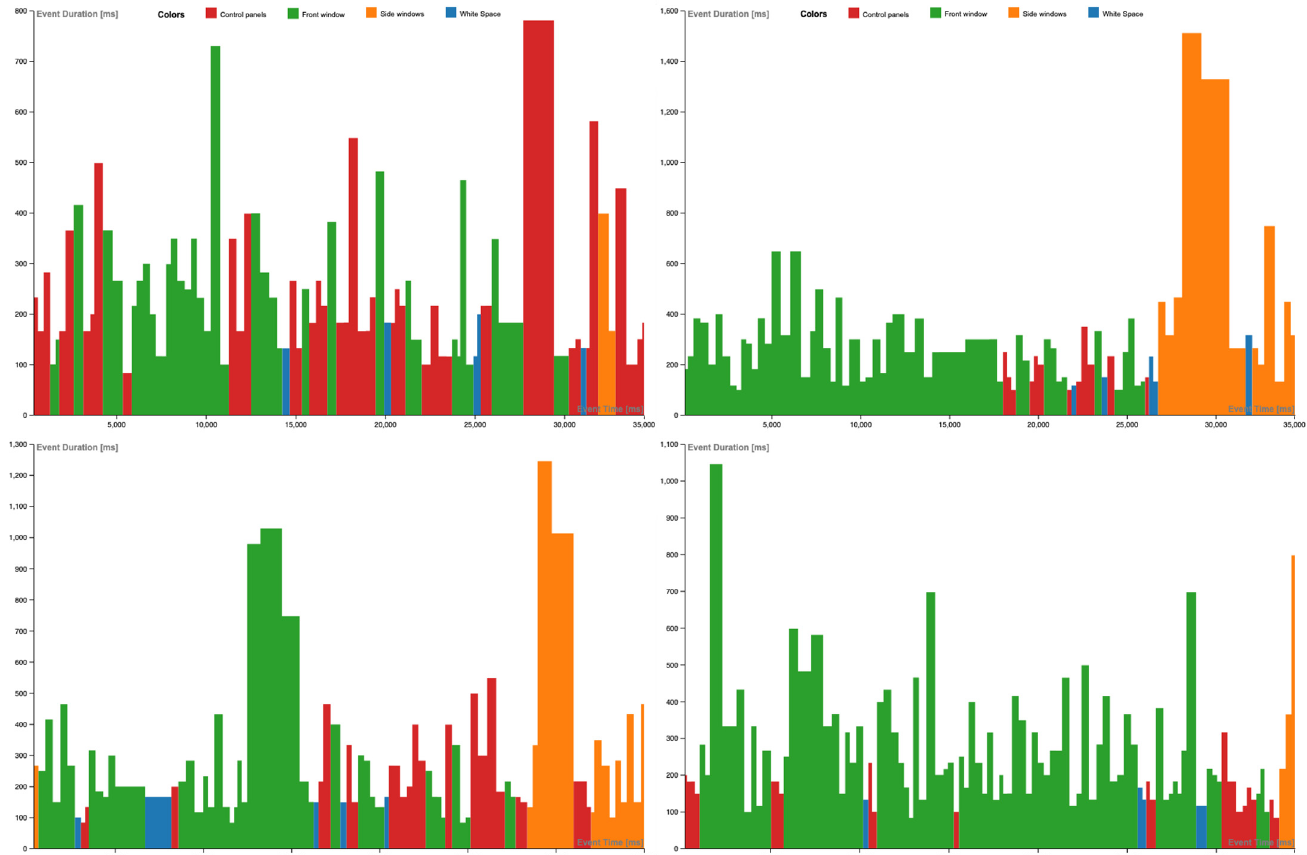
Figure 10. Analysis of fixations during train arrival at the station.